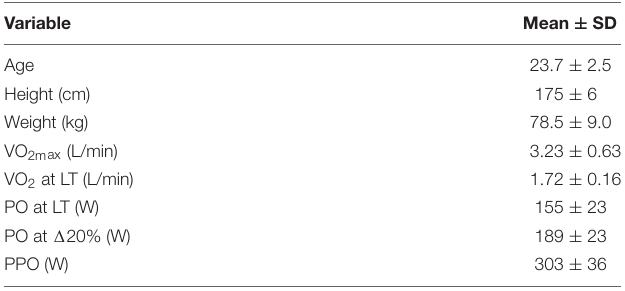
TABLE 1 | Baseline participant characteristics and results from the incremental ramp test ( n